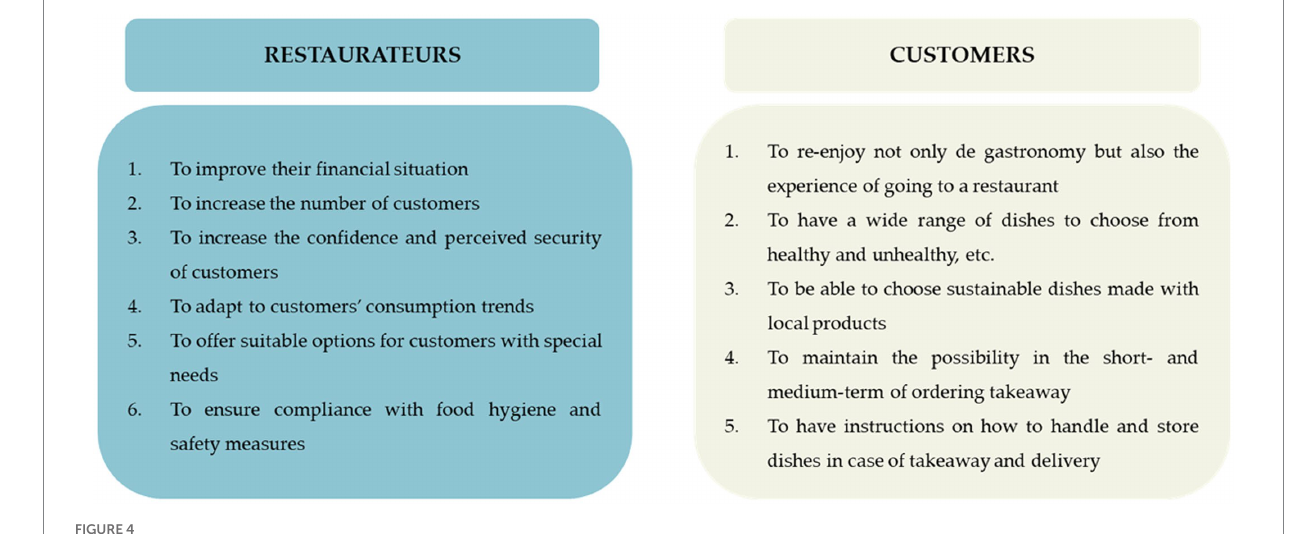
FIGURE 4 Needs and interests of restaurateurs and